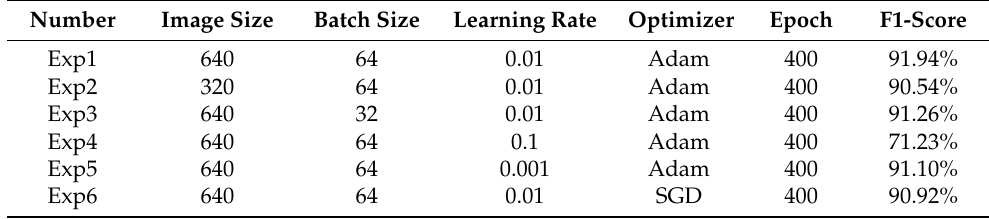
Table 7. Hyperparameter adjustment and results. Exp1–6 represents six experiments performed. Number Image Size Batch Size Learning